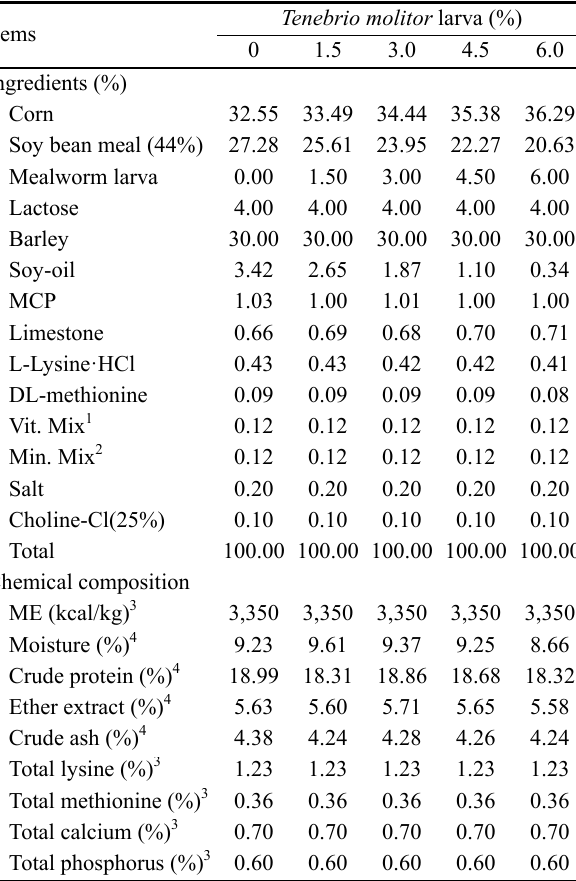
Table 3. The formula and chemical composition of experimental diets (phase II, d 14 to 35); as fed basis Items